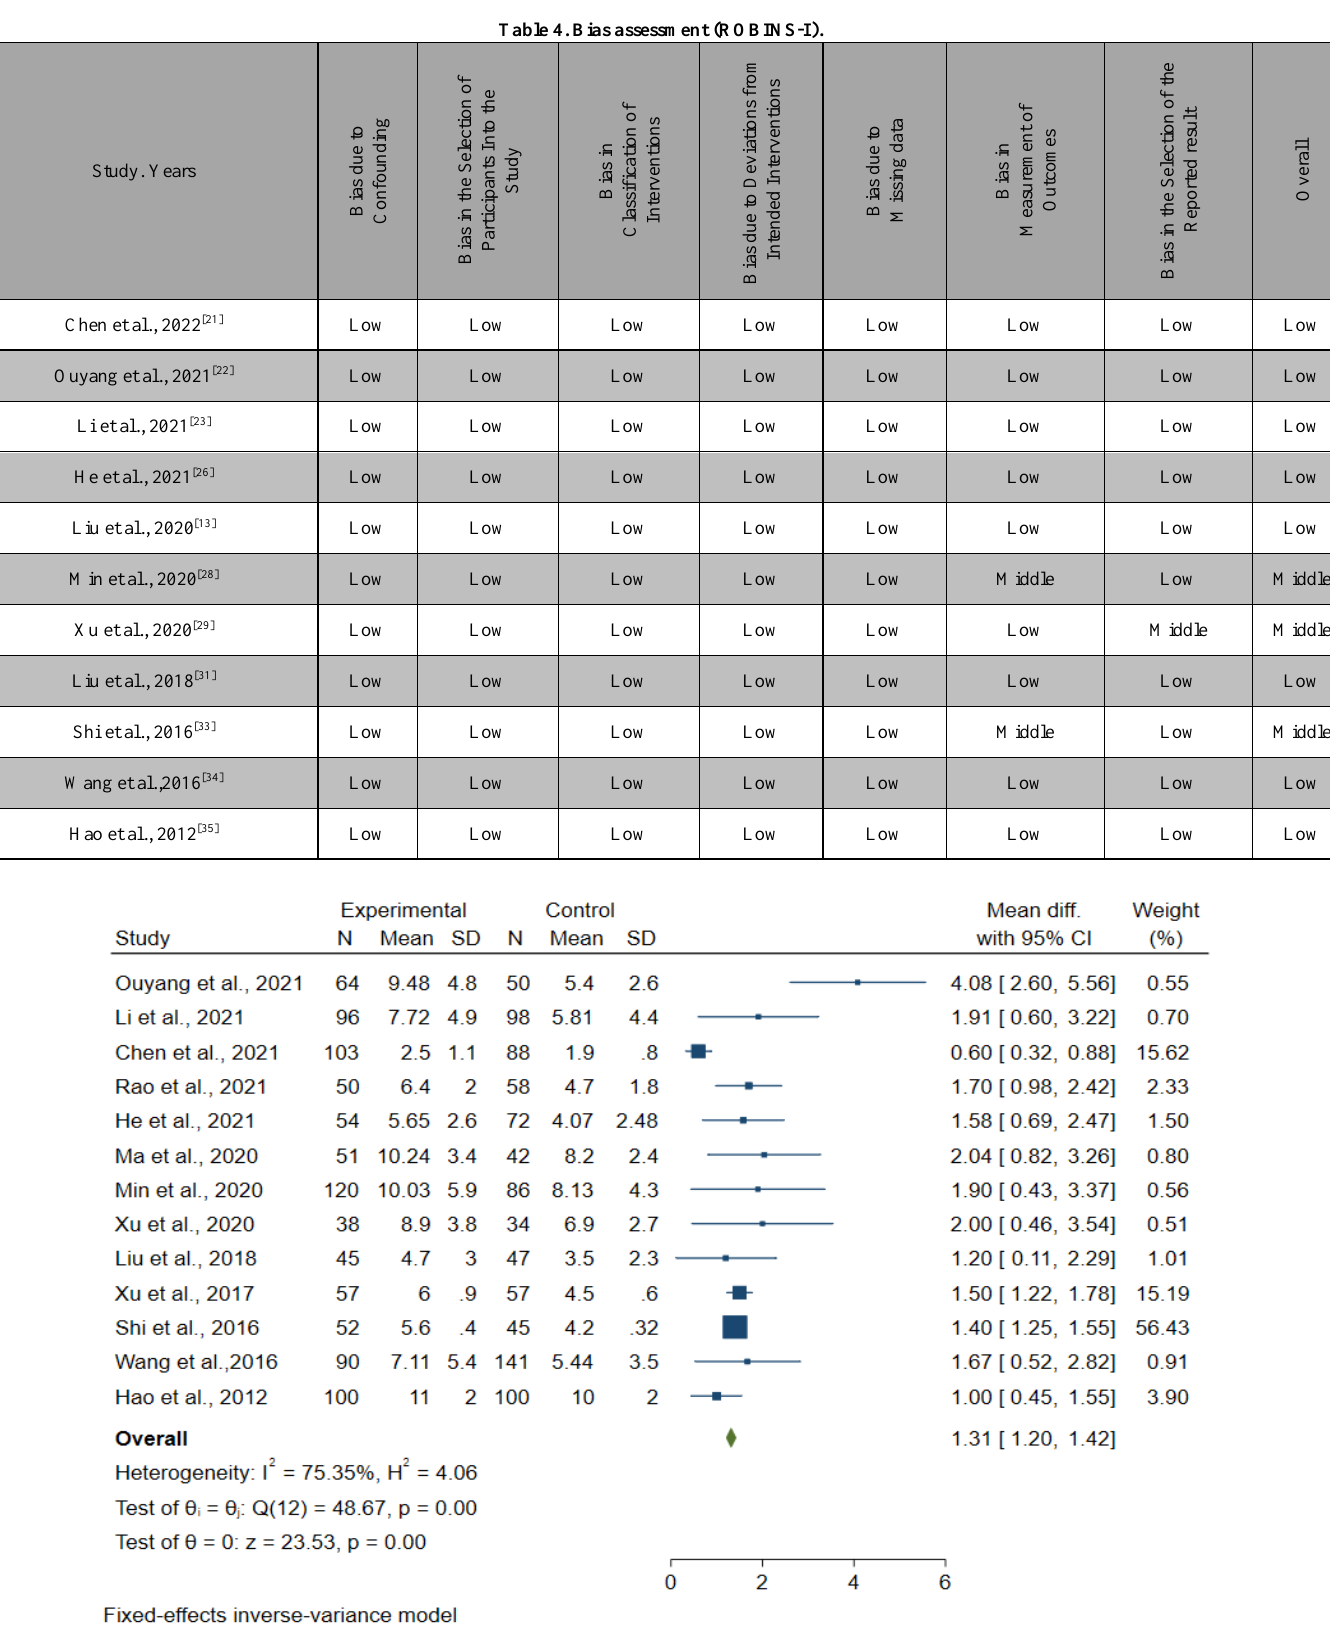
Table 4. Bias assessment (ROBINS-I).